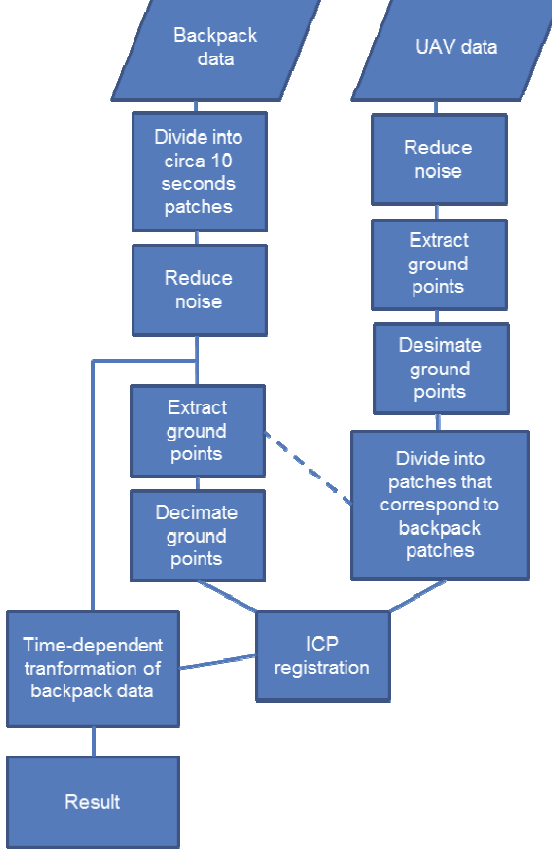
Figure 5. The workflow of BLS registration and correction algorithm.